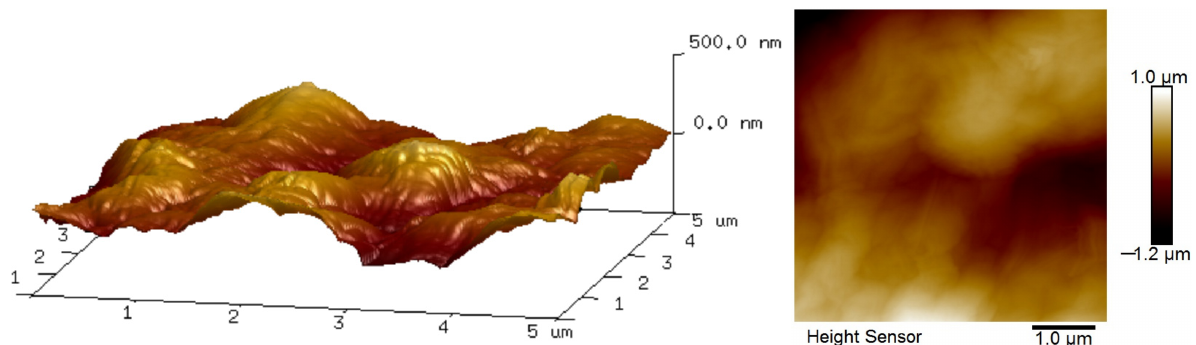
Figure 5. 3D AFM morphology of P84/GO composite membrane with chitosan.